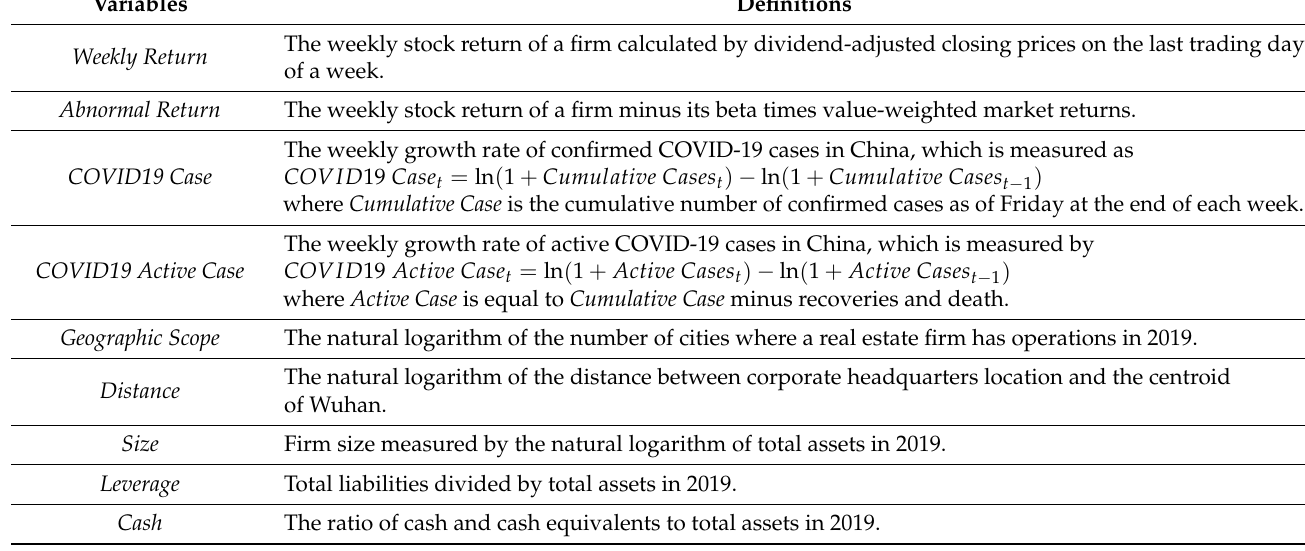
Table A1. Variable